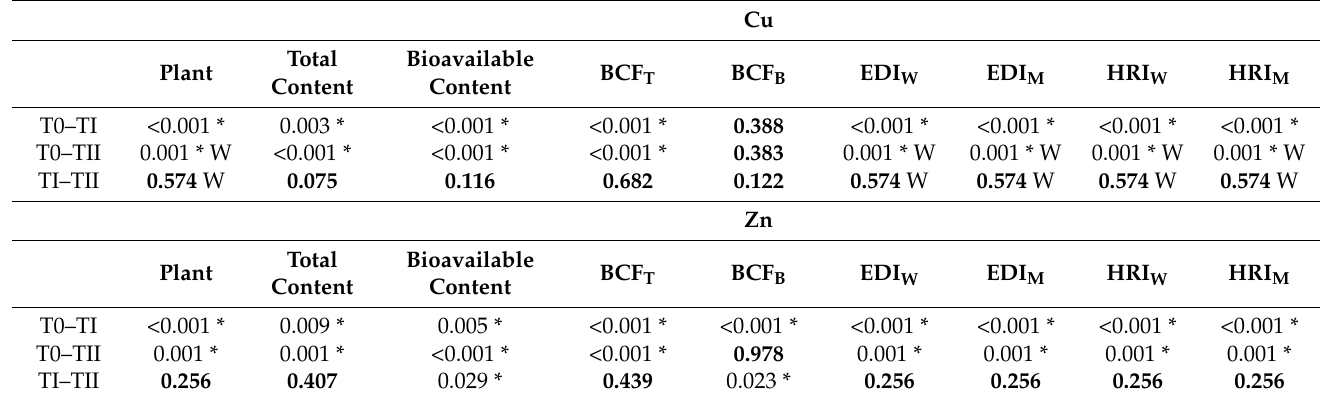
Table 3. The p -values from the comparisons of Cu and Zn contents in oat, soil and other parameters depending on the applied amendments (compost, TI and fly ash, TII) and their absence (control, T0).